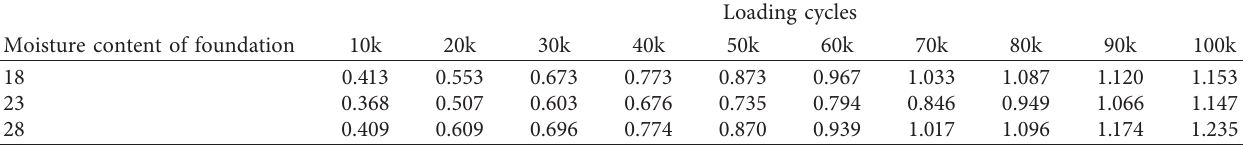
Table 5: Strain accumulation rate within 0.2 m of the top layer of the subgrade.